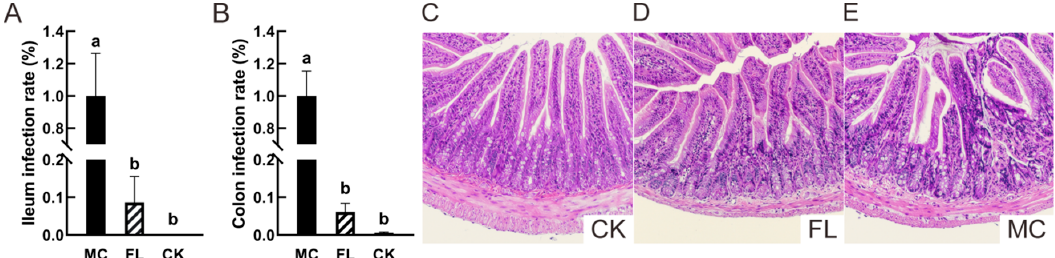
Figure 1. Escherichia coli O157 colonization and pathological section of ileum. ( A ) The colonization in ileum; ( B ) colonization in colon; ( C ) representative images of ileum tissue sections in the blank (CK) group (HE 100 × ); ( D ) representative images of ileum tissue sections in the FL group (HE 100 × ); ( E ) representative images of stained ileum tissue sections in the mode control (MC) group (HE 100 × ). Different letters (a, b) indicate significant differences among groups ( p < 0.05).